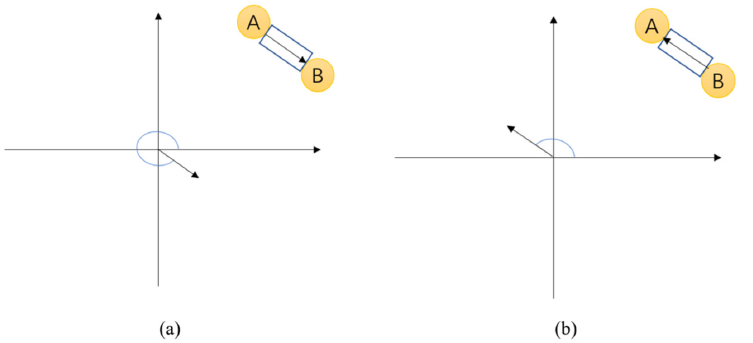
Figure 3. The definition of the proposed bidirectional graph: ( a ) represents the “top-to-down” direction prediction from node A to B; ( b ) represents the “down-to-top” direction prediction from node B to A.